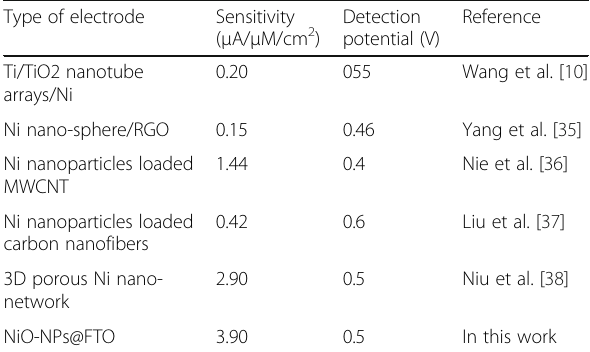
Table 1 Comparative study of analytical performance of the NiO-NPs@FTO-fabricated glucose